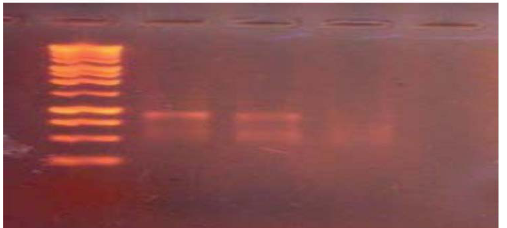
Fig. 1. Gel images generated of DNA obtained by ISSR 3